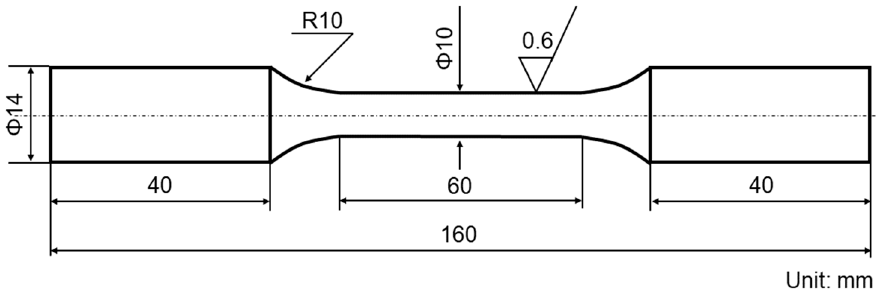
Figure 2. Dimensions of tensile